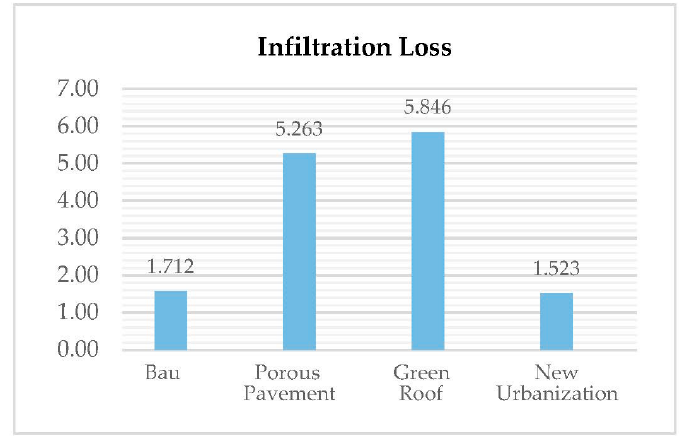
Figure 11. Comparison between infiltration loss results.